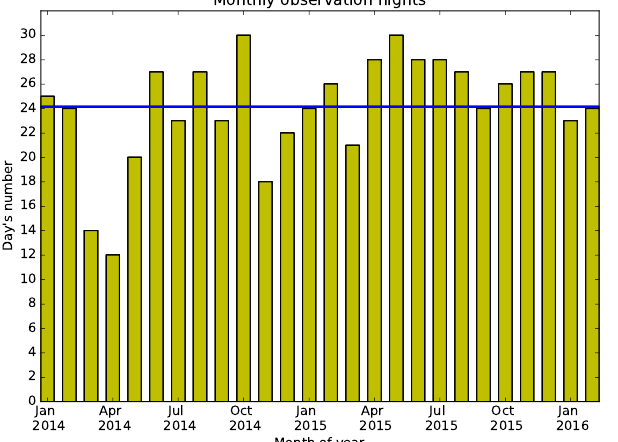
Figure 2. The number of observation nights per month from Jan- uary 2014 until February 2016. The blue bar denotes the average number of observations obtained each month over the period of study.